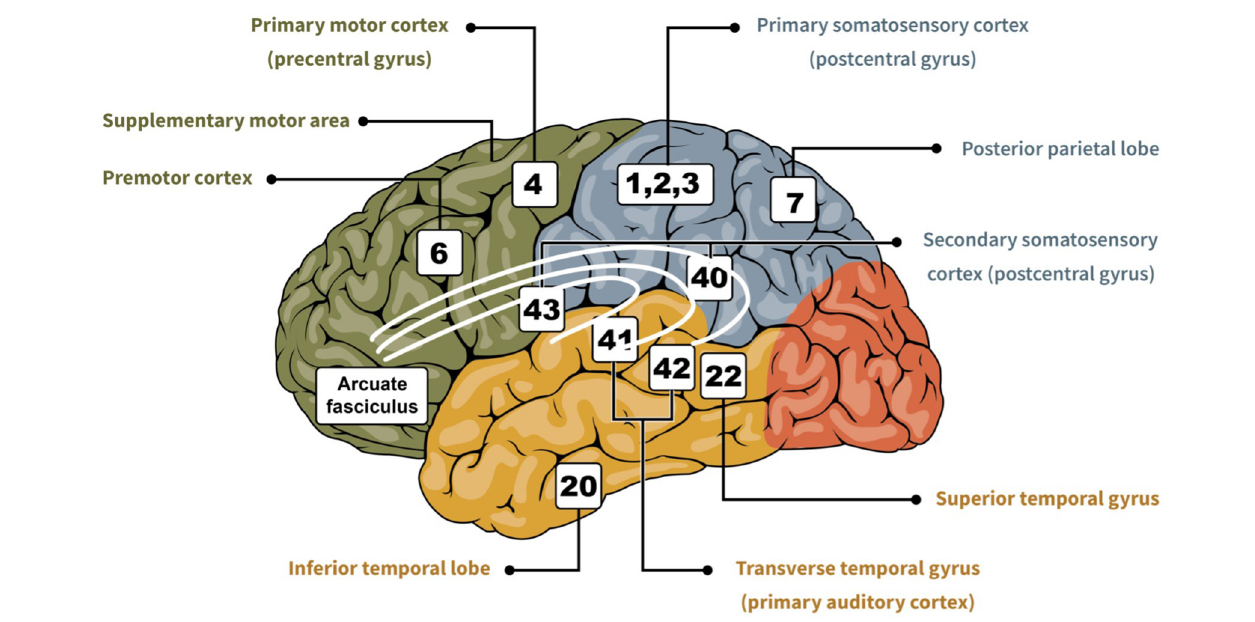
FIGURE 1 | Cartoon showing important regions of the brain related to sensorimotor integration (i.e., somesthetic, visual, and auditory). In green is the frontal lobe, in blue is the parietal lobe, in red is the occipital lobe, and in yellow is the temporal lobe. The numbers indicate the area based on the Brodmann classification (64), and each is associated with their respective